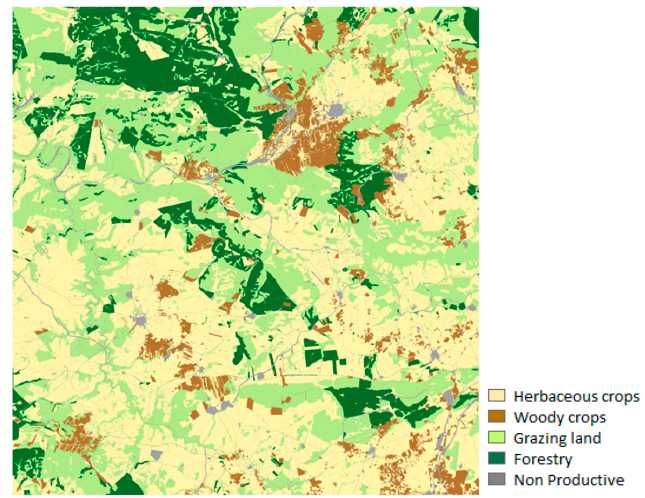
Figure 4. Land use classification in TS2 obtained from LPIS .